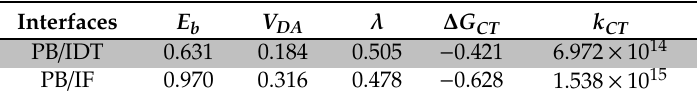
Figure 5. Energy levels of the NFAs IF-TN and IDT-TN and donor PBDB-T, and the charge transfer at the two interfaces (PB / IF and PB / IDT). Table 4. Calculated exciton binding energy E b (eV), charge transfer integral V DA (eV), reorganization energy λ (eV), Gibbs free energy change ∆ G CT (eV) and excitons separation rate k CT (s − 1 ) of two interfaces (PB/IF and PB/IDT).